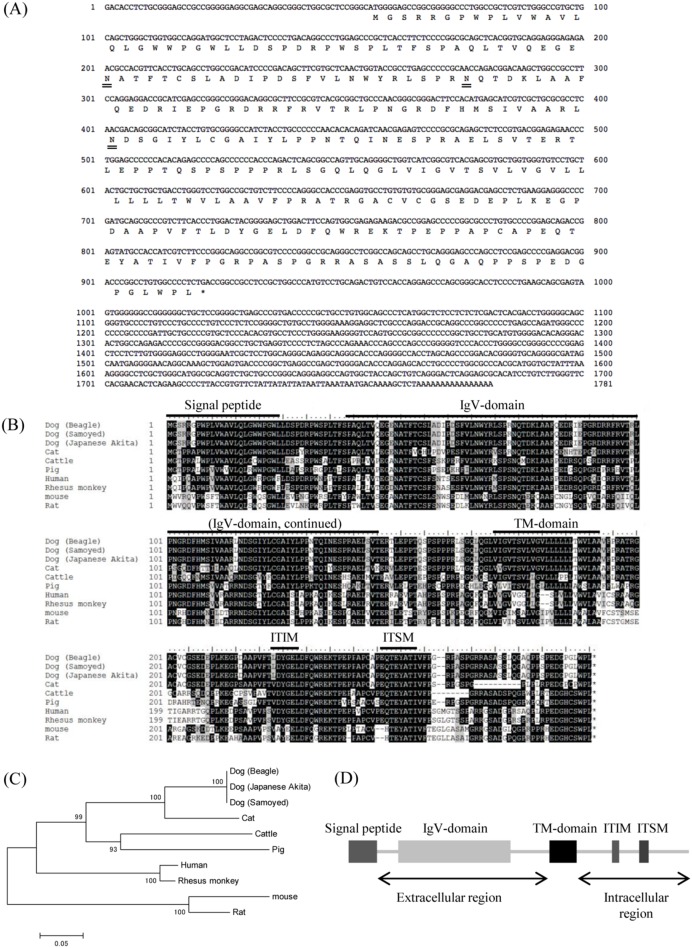
Sequence analysis of canine PD-1.(A) Nucleic acid and deduced amino acid sequences of canine PD-1 cDNA. Canine PD-1 cDNA encodes for a 288 amino acid polypeptide. Predicted N-glycosylation sites in the amino acid sequence of canine PD-1 are doubly underlined. (B) Multiple sequence alignment of vertebrate PD-1 amino acid sequences. Predicted domains and motifs of canine PD-1 are shown in the figure. Signal peptide, 1–24; IgV domain, 39–145; transmembrane domain, 170–192; ITIM, 223–228; ITSM, 246–253. (C) Phylogenetic tree of the canine PD-1 sequence in relation to those of other vertebrate species. The bootstrap consensus tree was inferred from 1000 replicates (the numbers next to the branches indicate the bootstrap percentage). The scale indicates the divergence time. (D) Schematic image of predicted functional motifs in canine PD-1. Canine PD-1 consists of an extracellular region, a transmembrane region, and an intracellular region.